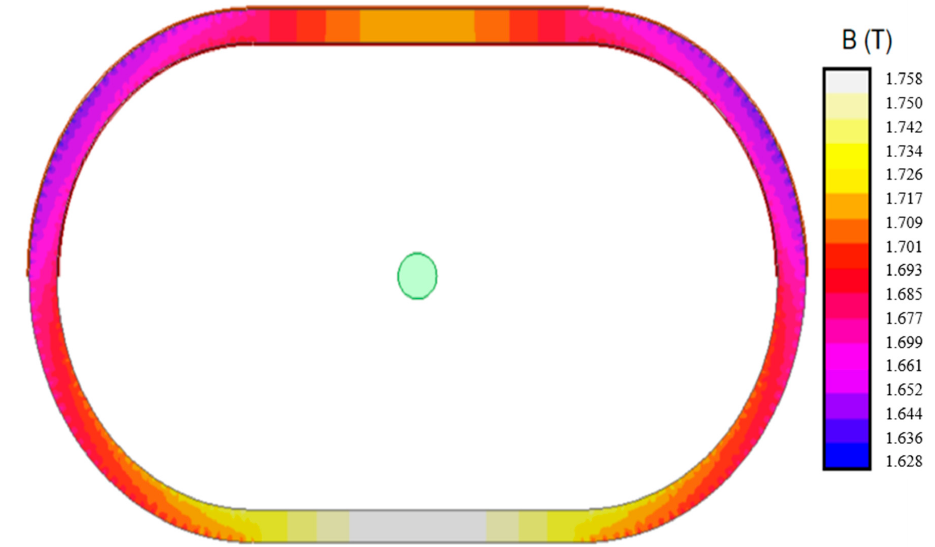
Figure 10. Flux density. Current transformer 500/1A 5P10 1VA. Partially distributed secondary winding. Primary current 5002 A, secondary current 6.021 A. Primary current 5002 A, secondary current 6.021